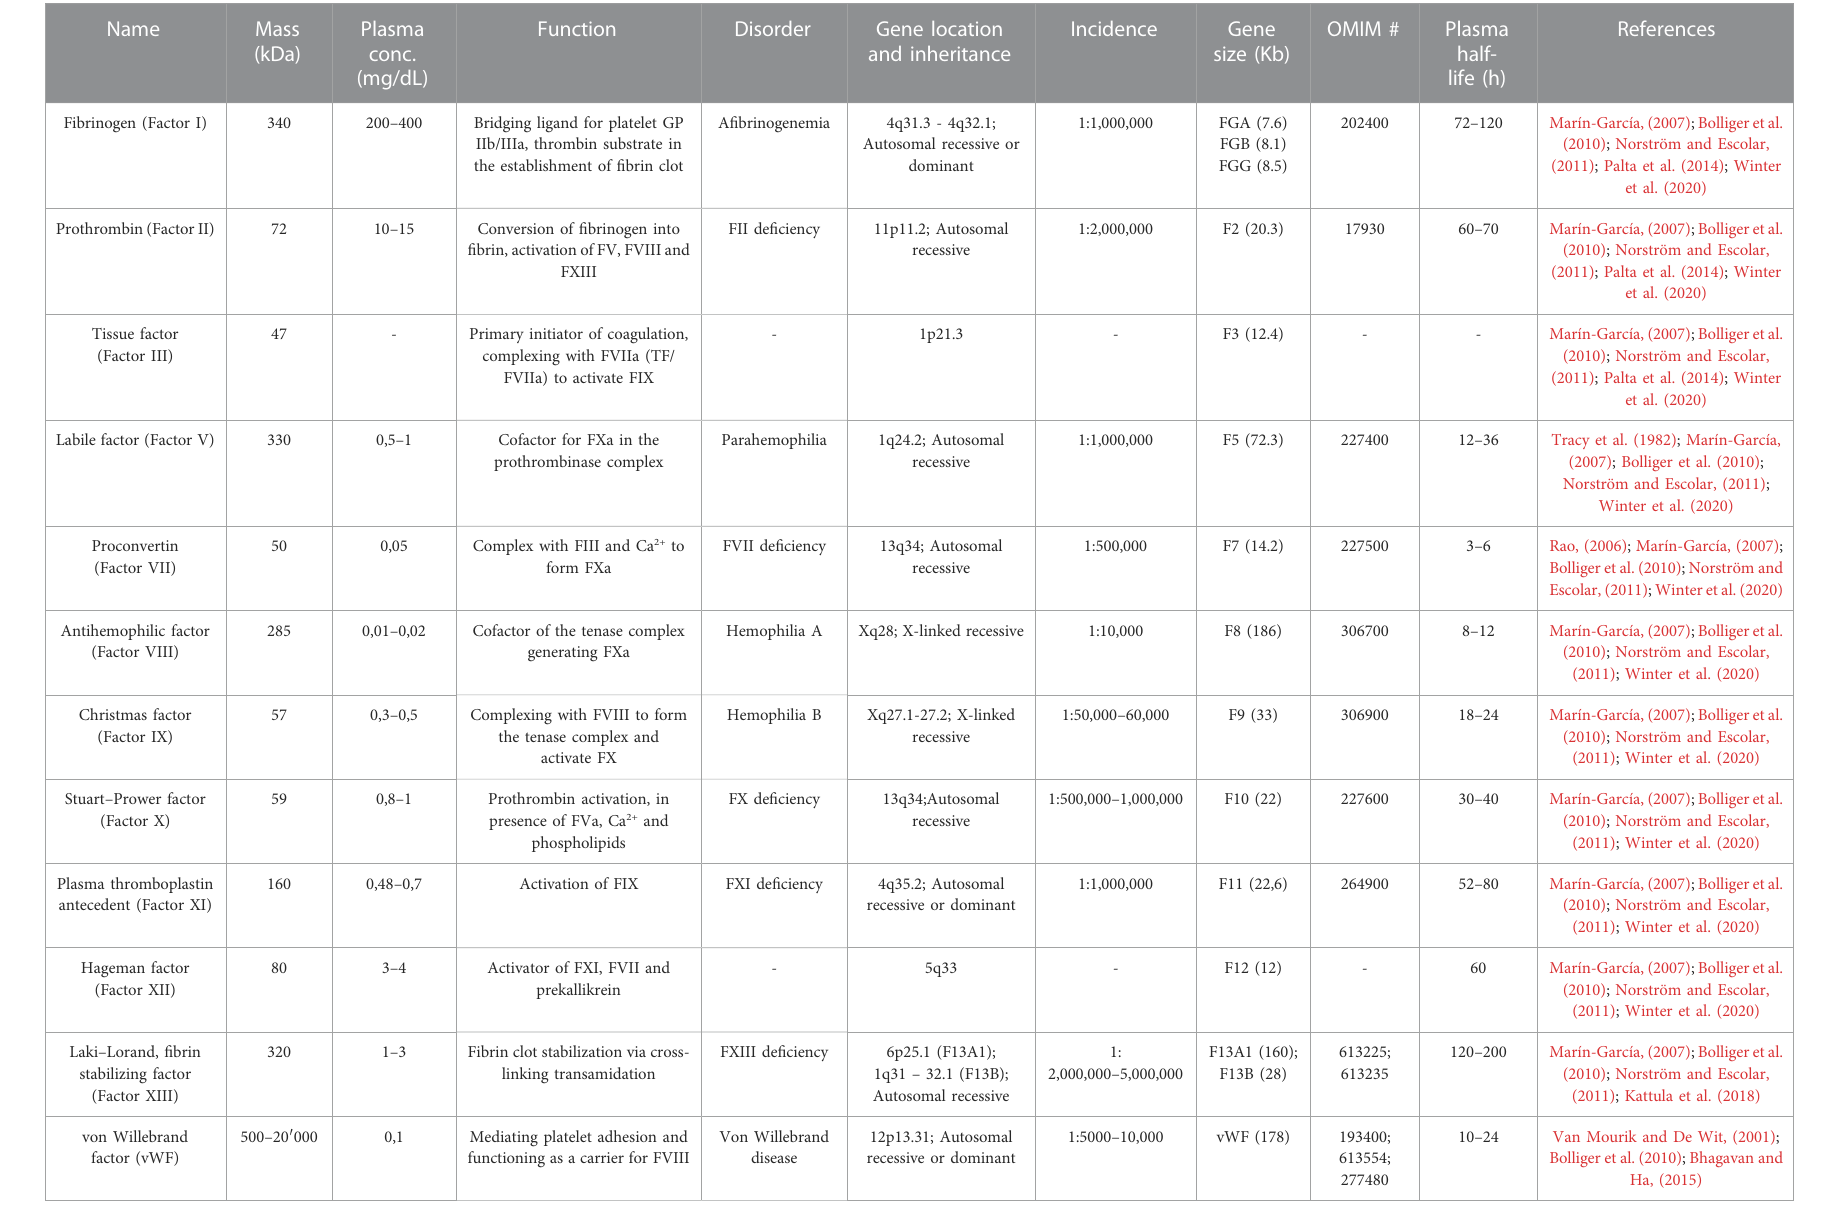
TABLE 1 Overview of the coagulation factors and the major associated disorders. Gene sizes and chromosomal locations from UCSC Genome Browser